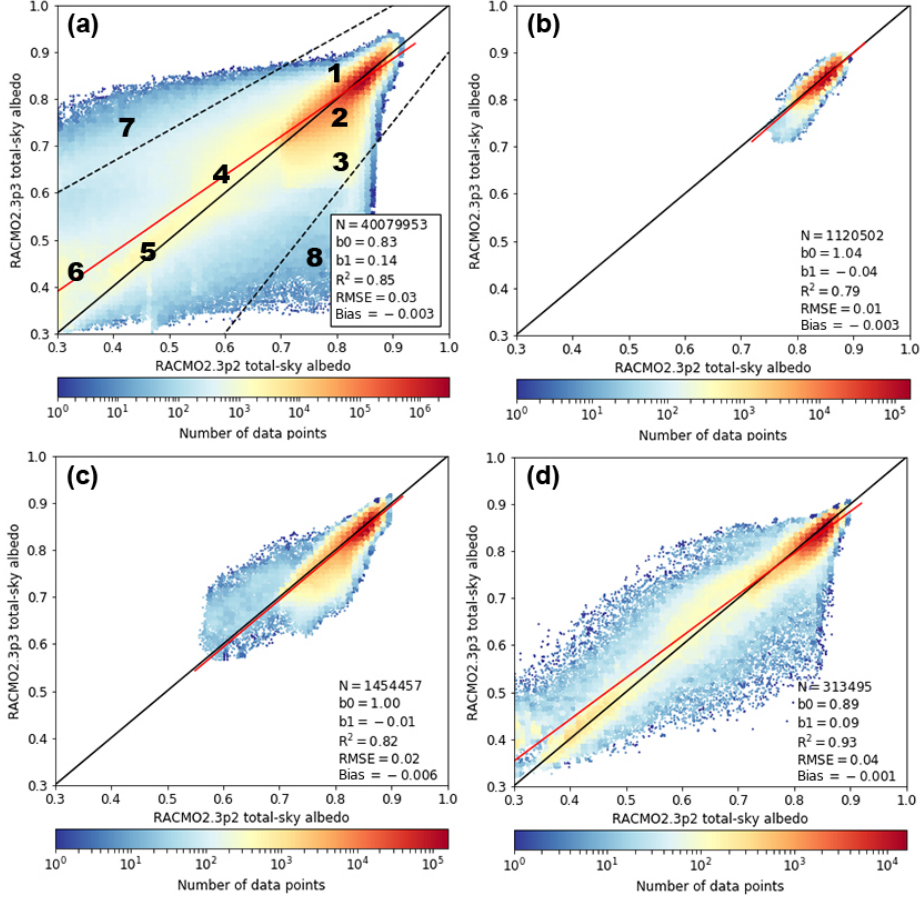
Figure 8. Comparison of 16d running mean total-sky albedo of RACMO2.3p3 with RACMO2.3p2 for 15:00UTC, between 2006 and 2015. Similar to Fig. 3, (a) shows all ice sheet points, while (b) , (c) and (d) show only grid cells in the brown, green and pink boxes in Fig. 2c, respectively. Numbers and dashed lines in (a) are discussed in the